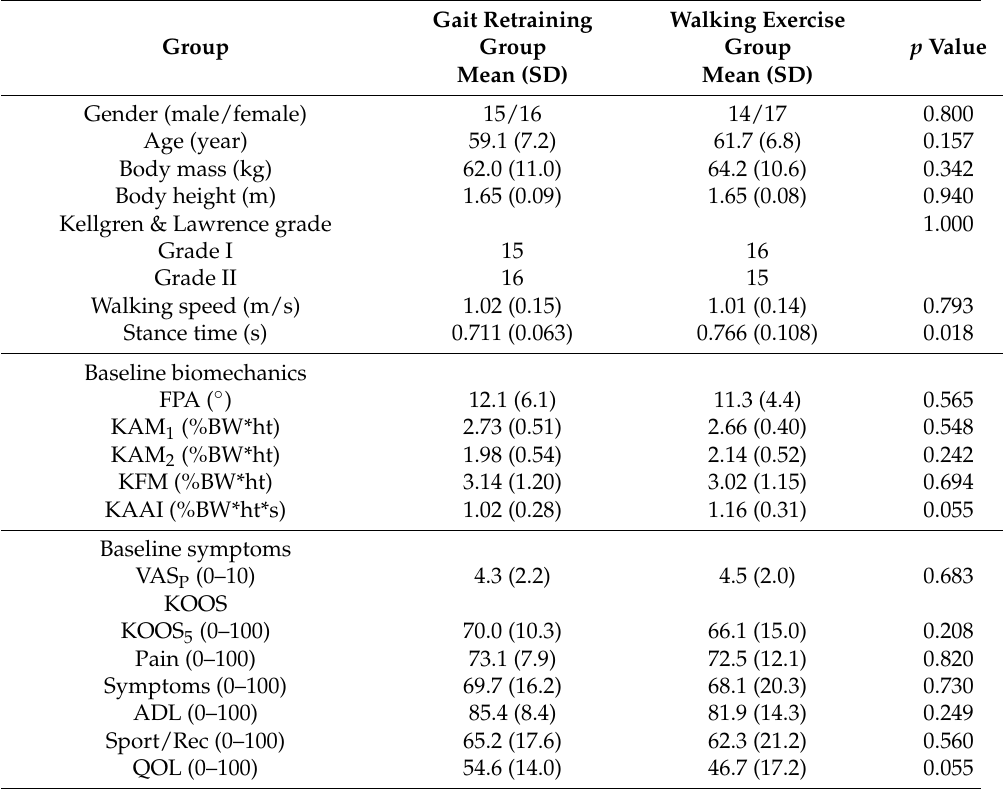
Table 1. Characteristics of